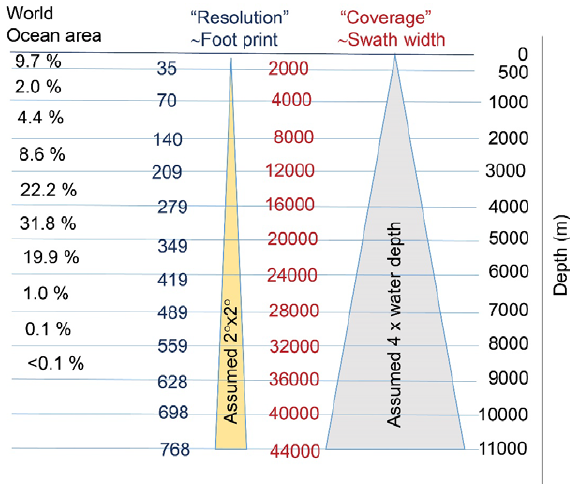
Figure 6. Footprint of outer (60° to one side) beam on seafloor (achievable lateral resolution) for 2° × 2° multibeam sonar, as a function of water depth. Swath width coverage (assuming 4× water depth) is shown in red. Left column is the percentage of the global seafloor in each depth bin. Note that in deepest water depths (>10 km) swath widths can be limited by attenuation.